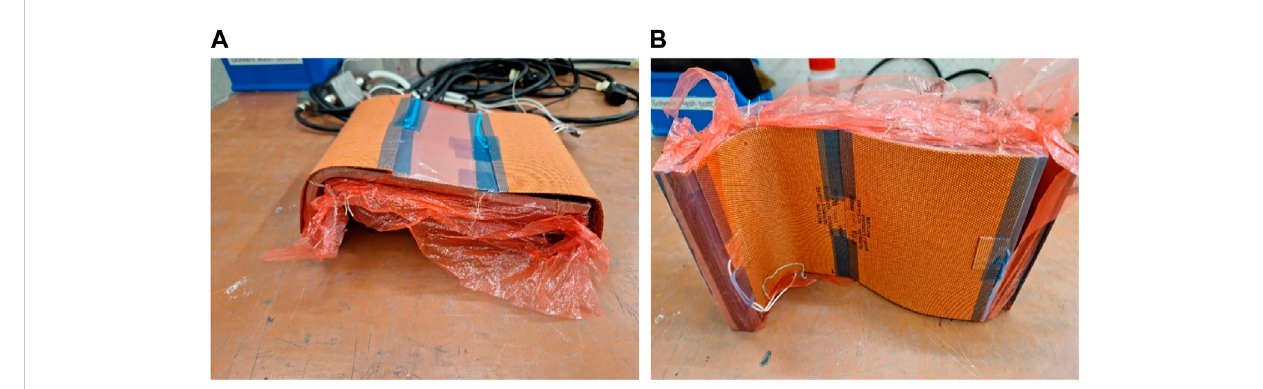
FIGURE 3 Part, pre-bagging, with heater mats on top surface (A) and bottom surface (B) , showing placement and